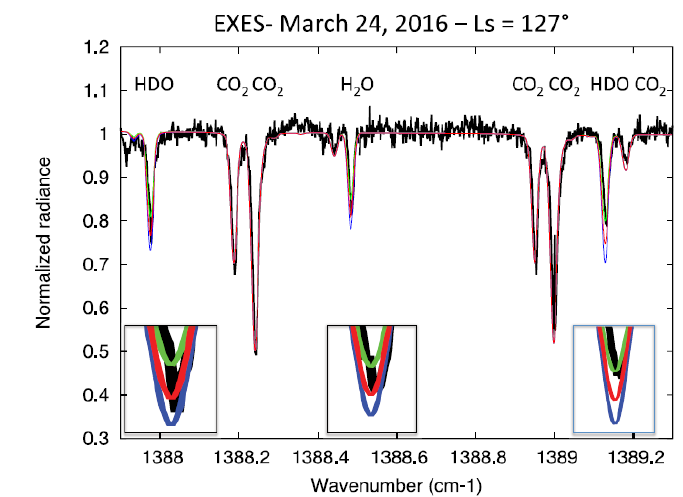
Figure 4. Determination of the D/H ratio on Mars—observations by EXES, onboard SOFIA, at approximately 1383–1391 cm − 1 . Spectrum of the northern hemisphere of Mars in March 2016. The stronger lines are from CO 2 and there are several weaker HDO and H 2 O lines. In Section 4, the HDO line at 1388 cm − 1 , the HDO line at 1389.1 cm − 1 and the H 2 O line at 1388.5 cm − 1 were modeled for different H 2 O and HDO abundances to estimate the D/H ratio. Green: H 2 O = 250 ppm, HDO = 400 ppb; red: H 2 O = 375 ppm, HDO = 550 ppb; blue: H 2 O = 500 ppm, HDO = 700 ppb. (image credits: Encrenaz et al. [34]).